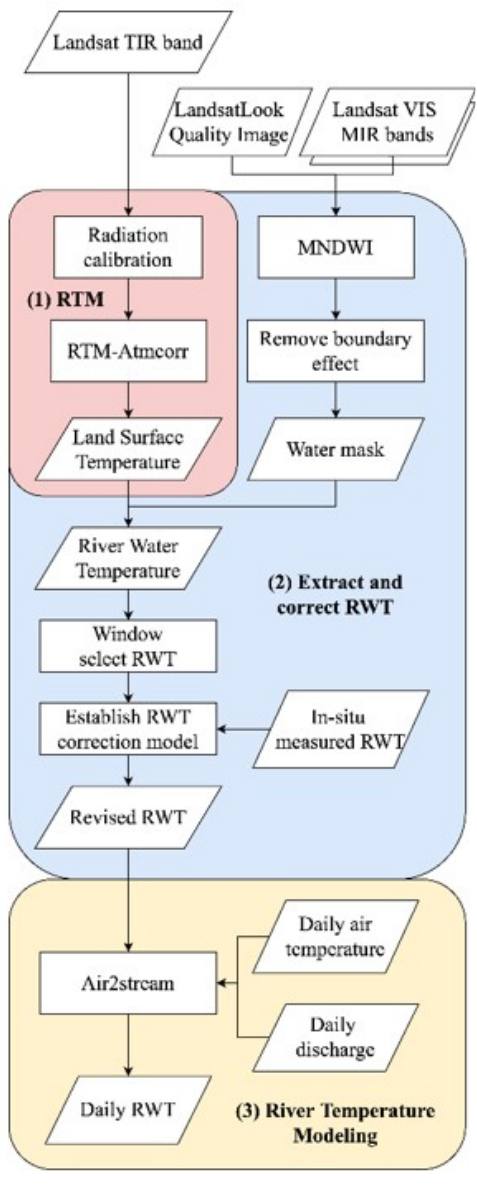
Figure 2. The Landsat thermal infrared (TIR) data processing flow